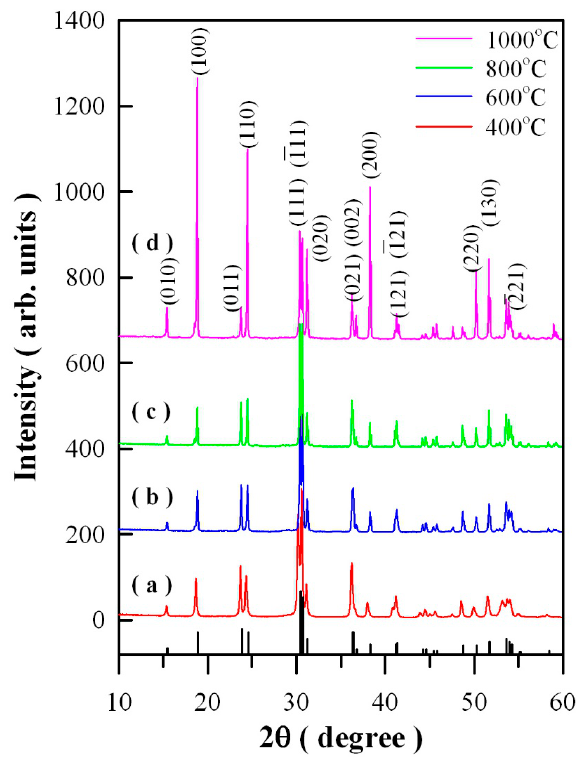
Figure 1. X-ray diffraction curves of Eu-doped ZnWO 4 precursors subjected to annealing at different temperatures: ( a ) 400 °C ; ( b ) 600 °C ; ( c ) 800 °C ; and ( d ) 1000 °C . The standard diffraction data of monoclinic ZnWO 4 are shown at the bottom for comparison.